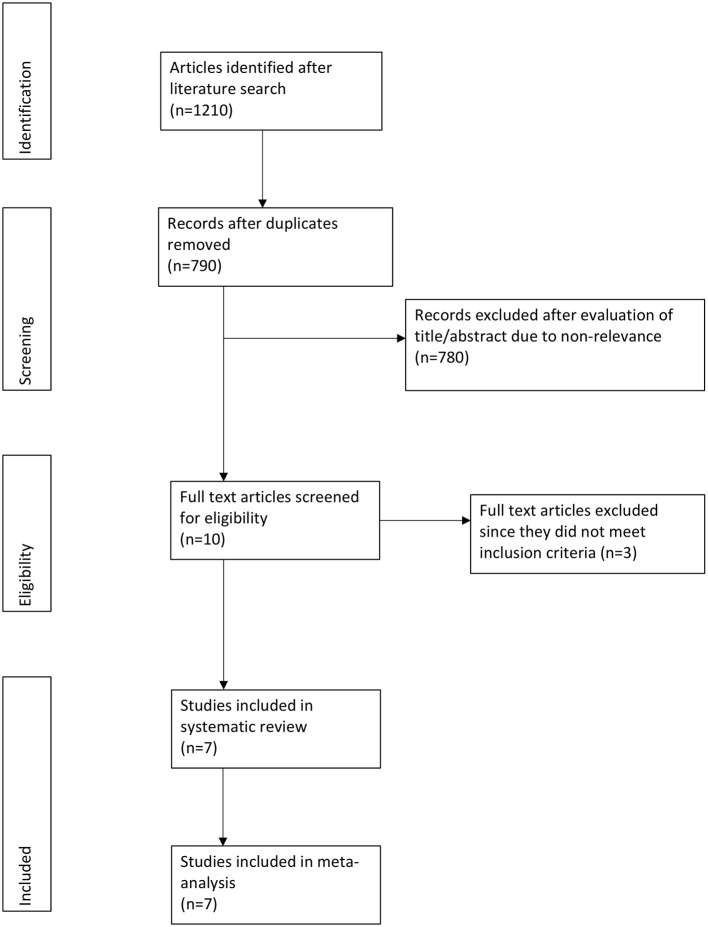
Study flow chart.